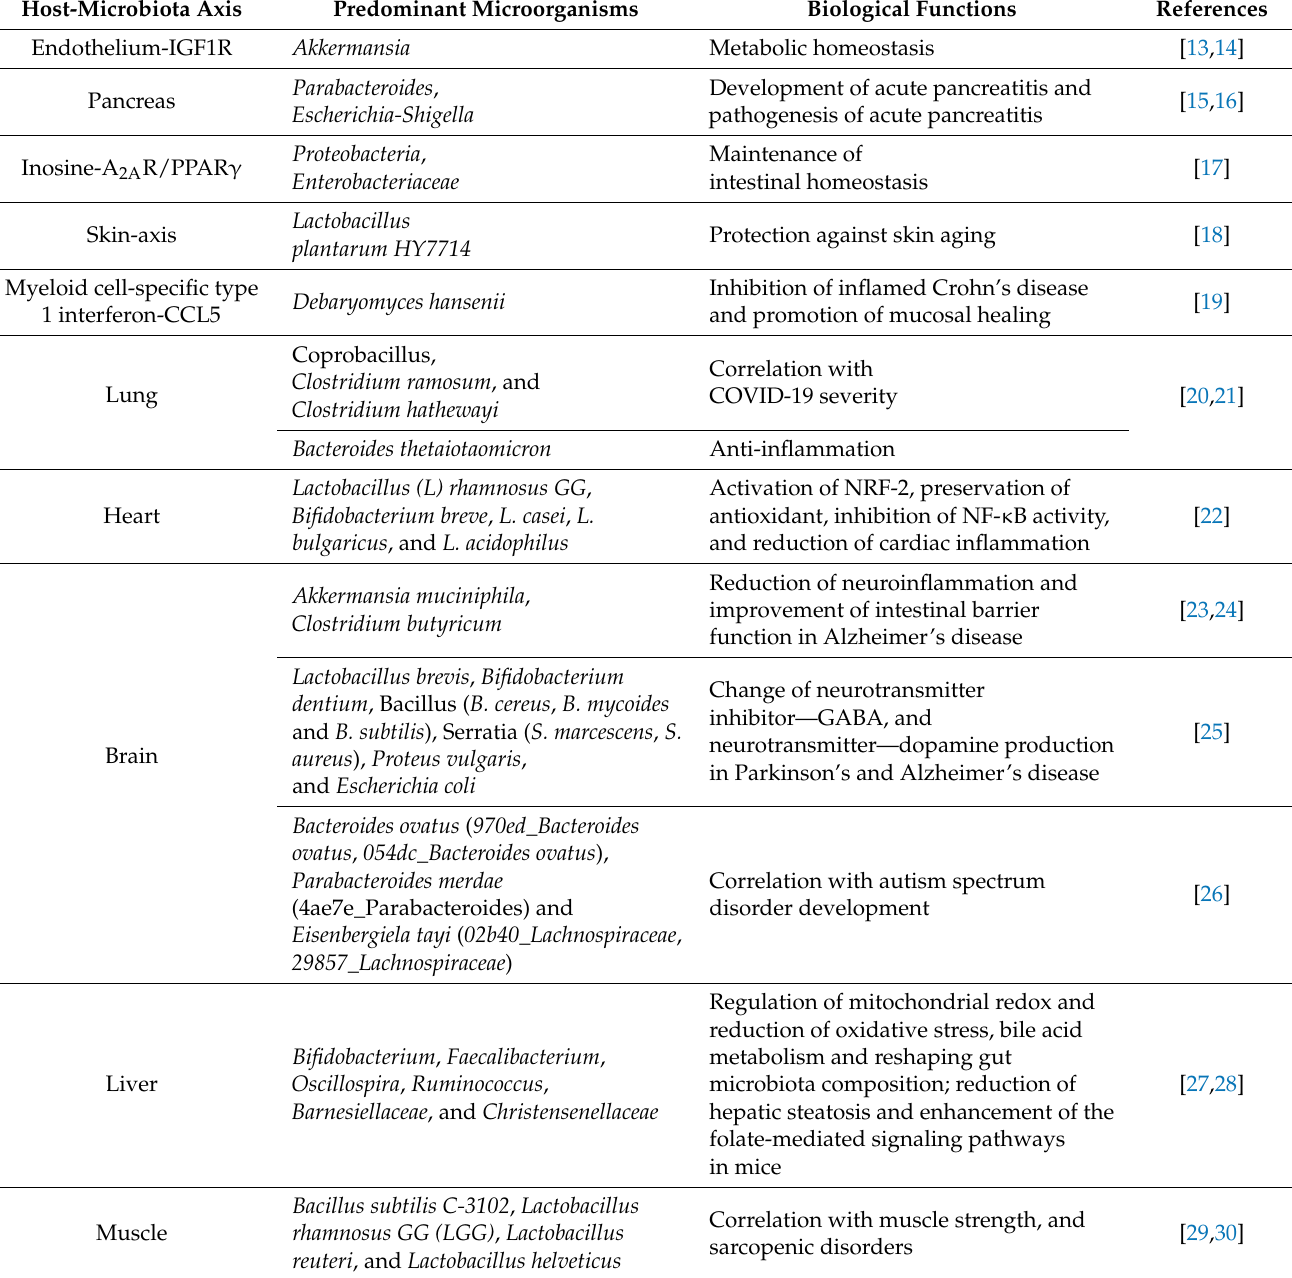
Table 1. Multifaceted functions of gut microbiota to host tissue metabolism and